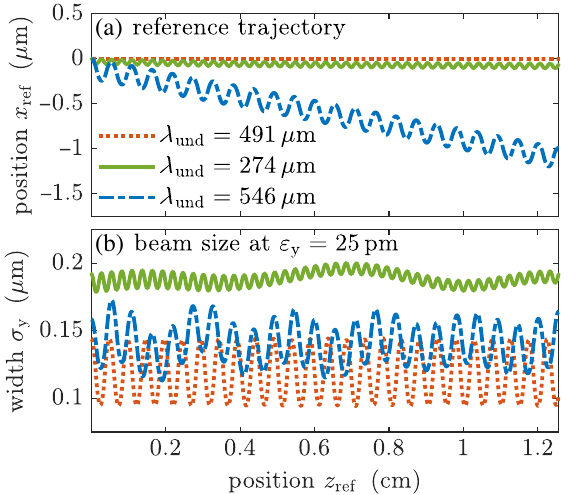
FIG. 10. DLA track6 D simulations of the reference trajectory in (a) and transverse rms size in (b) of an electron beam with ε y ¼ 25 pm and ε ε 0 emittance for three different setups of the x ¼ z ¼ 90 ° synchronous DLA undulator lattice. The setup for φ s ¼ 491 μ m provides maximum synchronous phase with λ und ¼ focusing but no transverse deflection. The other setups compare 38 . 2 ° in two lattice designs with the beam dynamics for φ s ¼ . different undulator wavelengths λ und